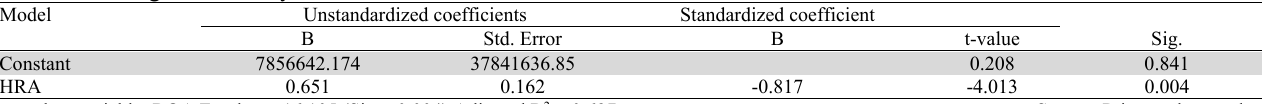
The results of regression analysis Model